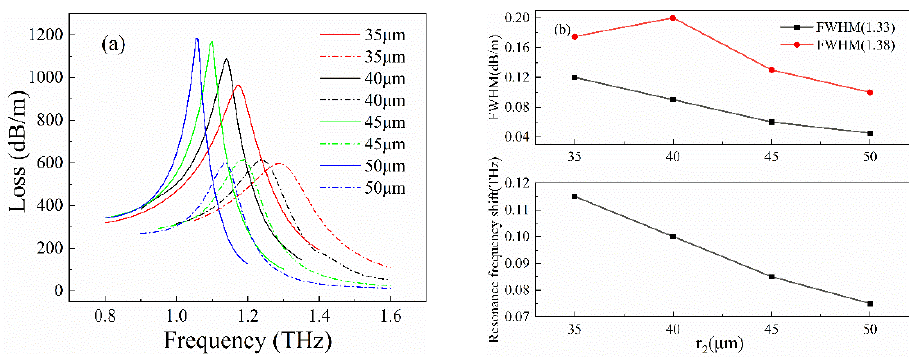
Figure 4. ( a ) Loss peak curves of different r 2 . ( b ) FWHM and resonance frequency shift of different r 2 .